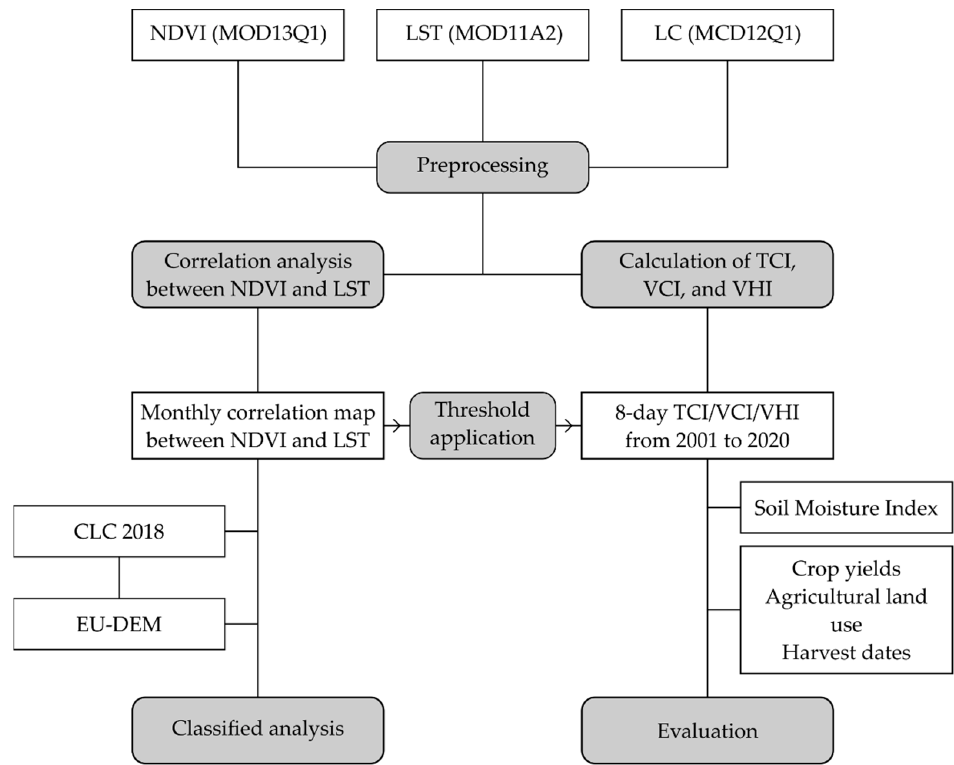
Figure 1. Flowchart of data used and processed (white boxes) and methodology applied (gray boxes; NDVI = Normalized Difference Vegetation Index; LST = Land Surface Temperature; LC = Land Cover; TCI = Temperature Condition Index; VCI = Vegetation Condition Index; VHI = Vegetation Health Index; CLC = Corine Land Cover; EU-DEM = European Digital Elevation Model).